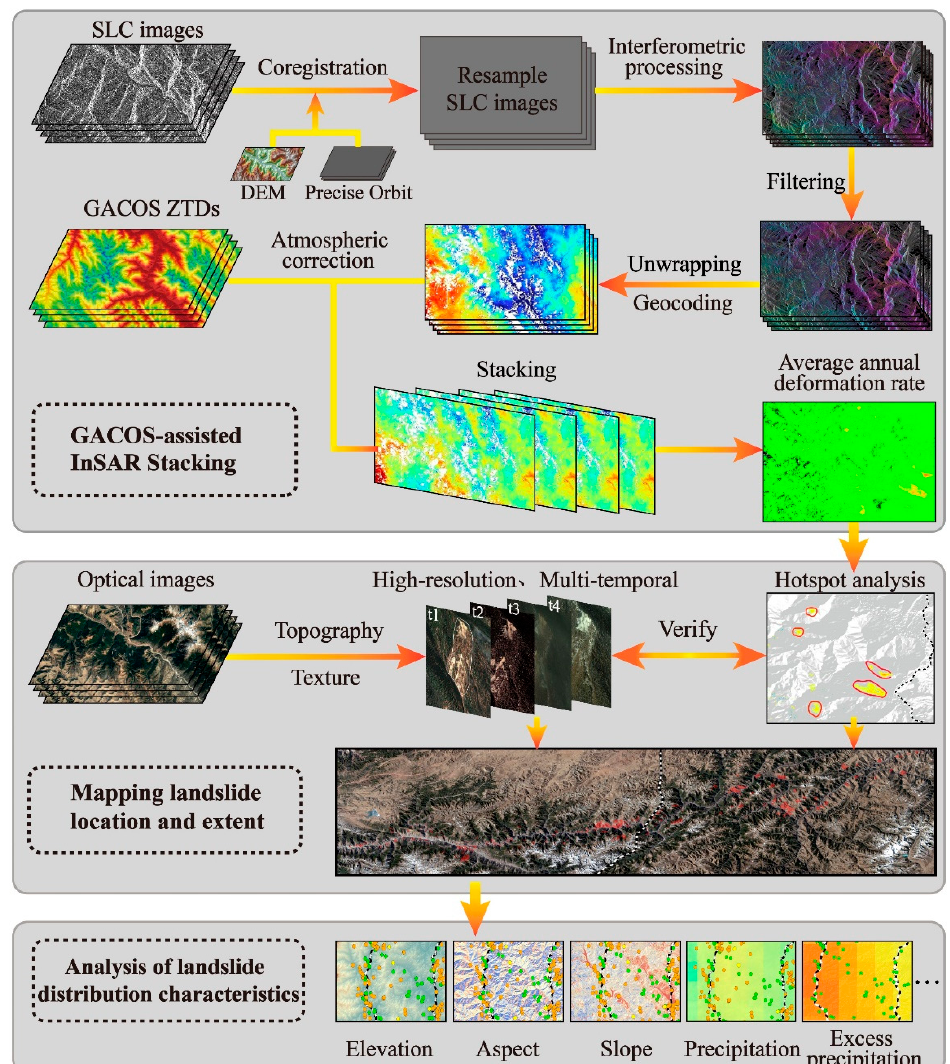
Figure 4. Flowchart for landslide detection and analysis.